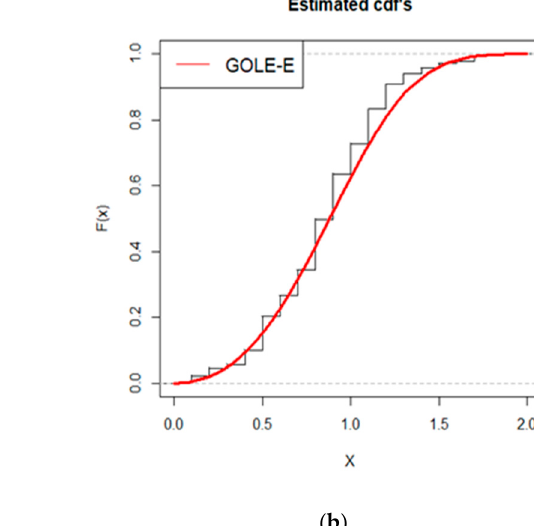
Table 6. The AIC, BIC, CAIC, HQIC, A*, W* and KS ( p -value) values for data set II.